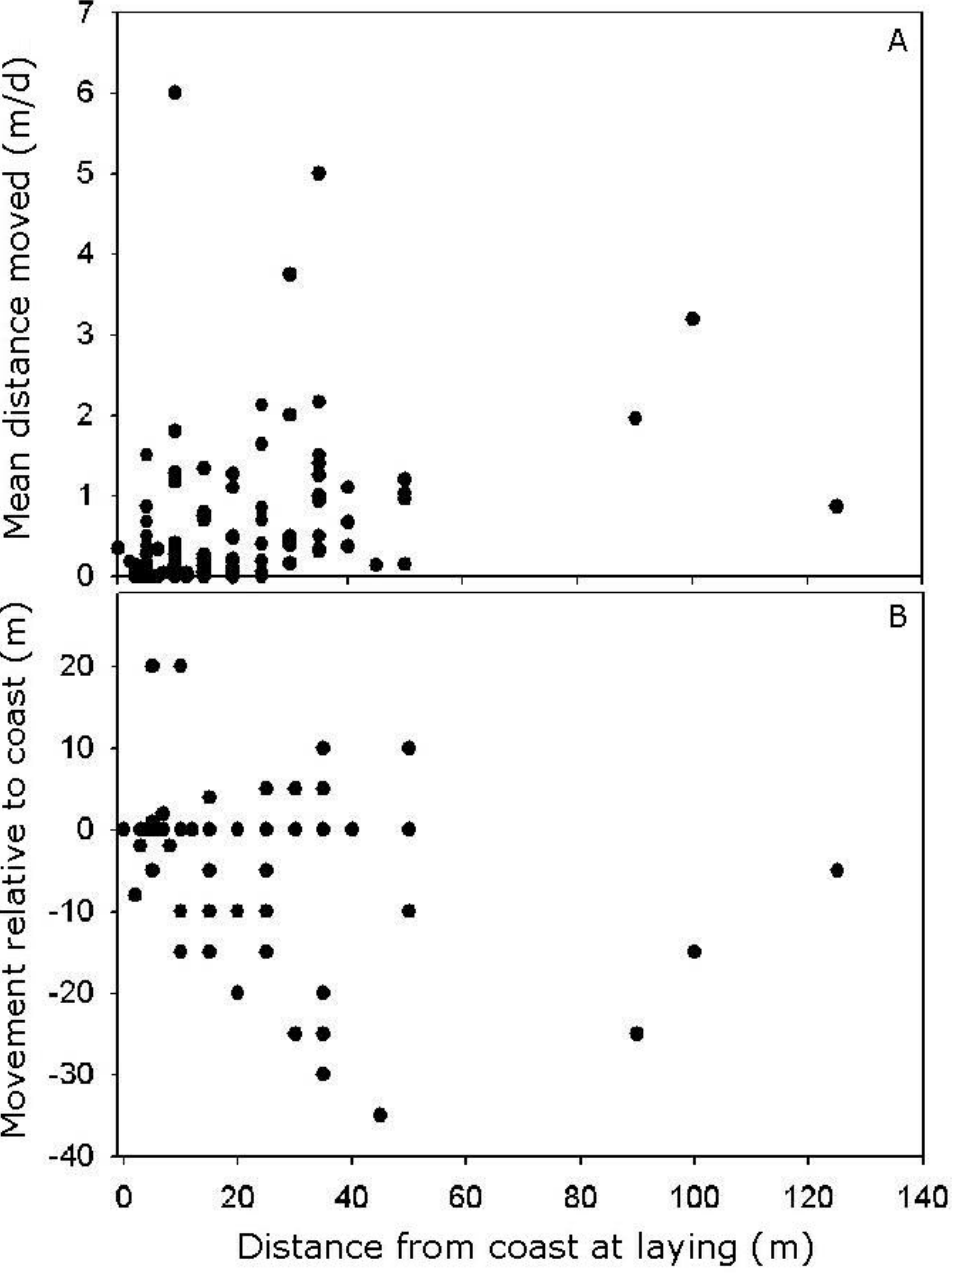
Fig. 6 . Distance from coast at laying for 153 nests in 2003 with average daily distance moved (A) and movement relative to coastline (B) during 30 d of nest